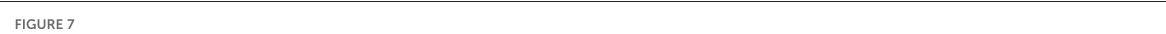
FIGURE7 Magnified photographs from the box-indicated regions in (A–E) show the details. (A–E) After the operation, neuronal shrinkage and loss showed up in the area of the infarcts, and the amount of cleaved caspase-3 increased. (F) The area ratio of neurons showed an increasing trend of neuronal apoptosis after the operation. (G) The area ratio of caspase-3 significantly increased at 6h after the operation. The neuronal degeneration in all model rats presented with a similar pattern ( n = 7). The green dots in (B–D) were lodged in fluorescent microspheres. Scale